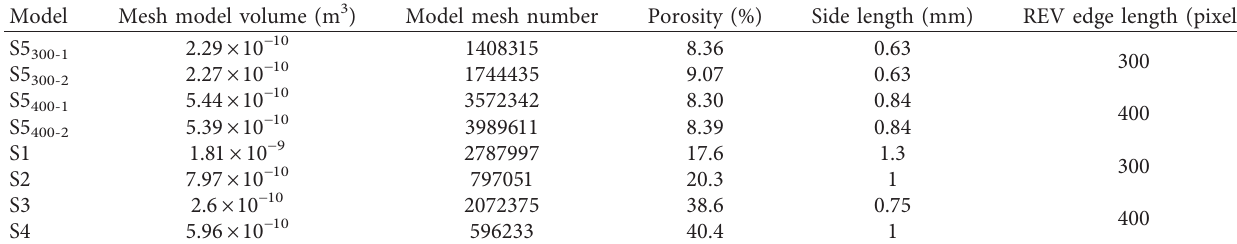
Table 5: Detailed parameters of RVEs of digital